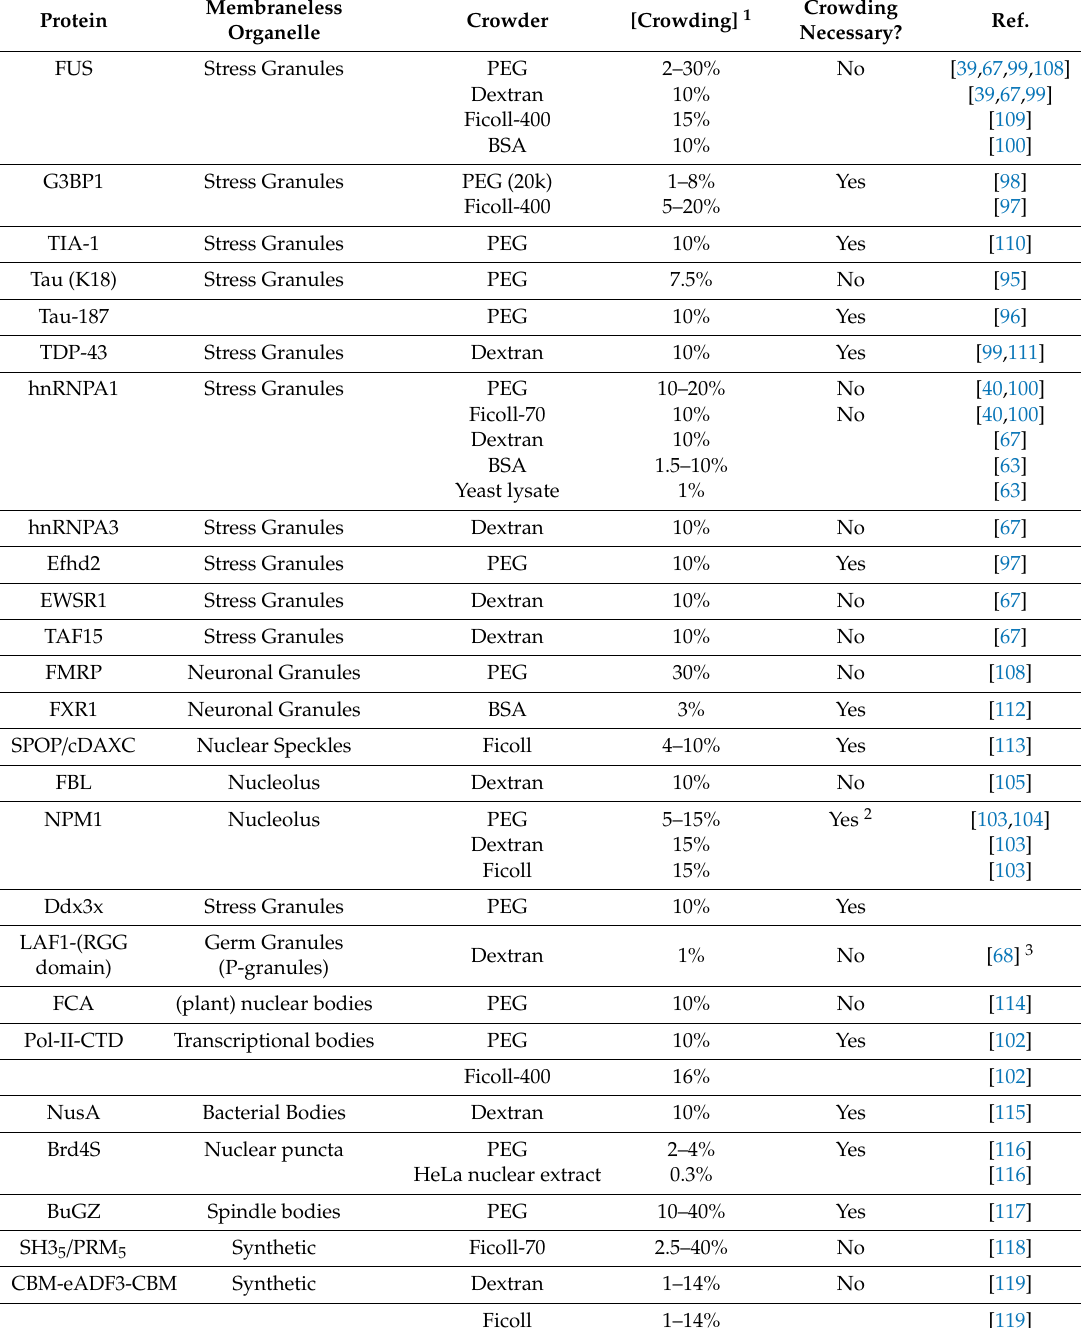
Table 1. Crowding agents that have been used to induce or promote protein phase separation in vitro.